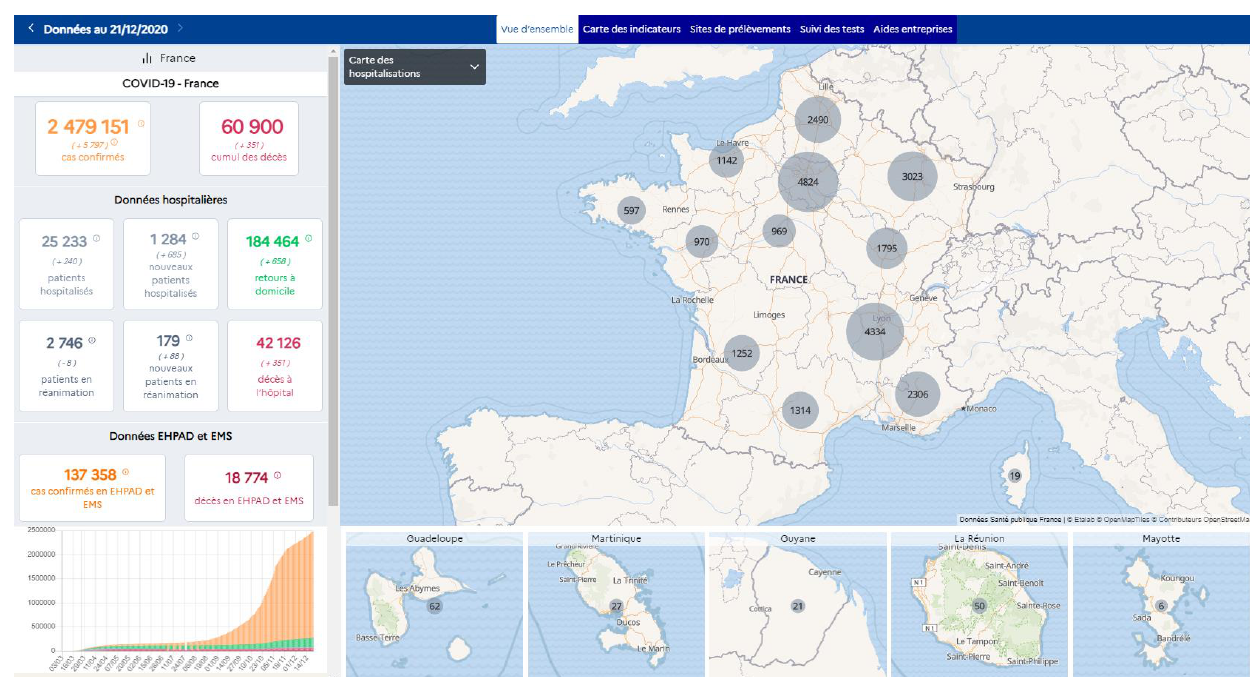
Figure 3. Dashboard France—situation on 21 December 2020 [20], https://dashboard.covid19.data.gouv.fr/vue-d-ensem- ble?location=FRA.